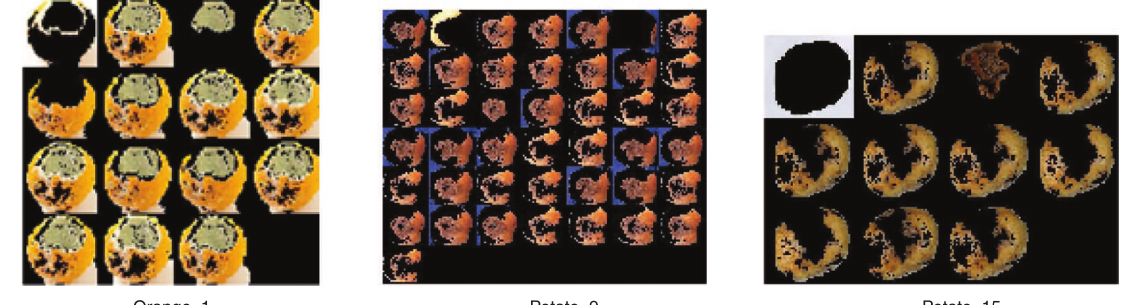
Figure 7: Segmented Images.